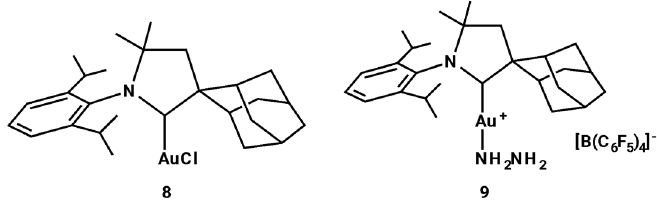
Figure 5. Complexes studied from Bertrand.